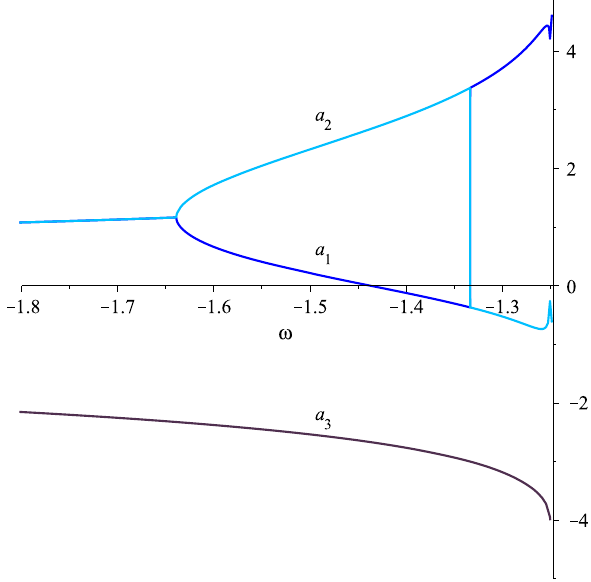
Fig. 1 Real parts of the eigenvalues corresponding to P 2 + . The curves corresponding to a 1 and a 2 are superposed to the left of approx. ω = − 1 . 64, and they show a discontinuity at ω = − 4 /